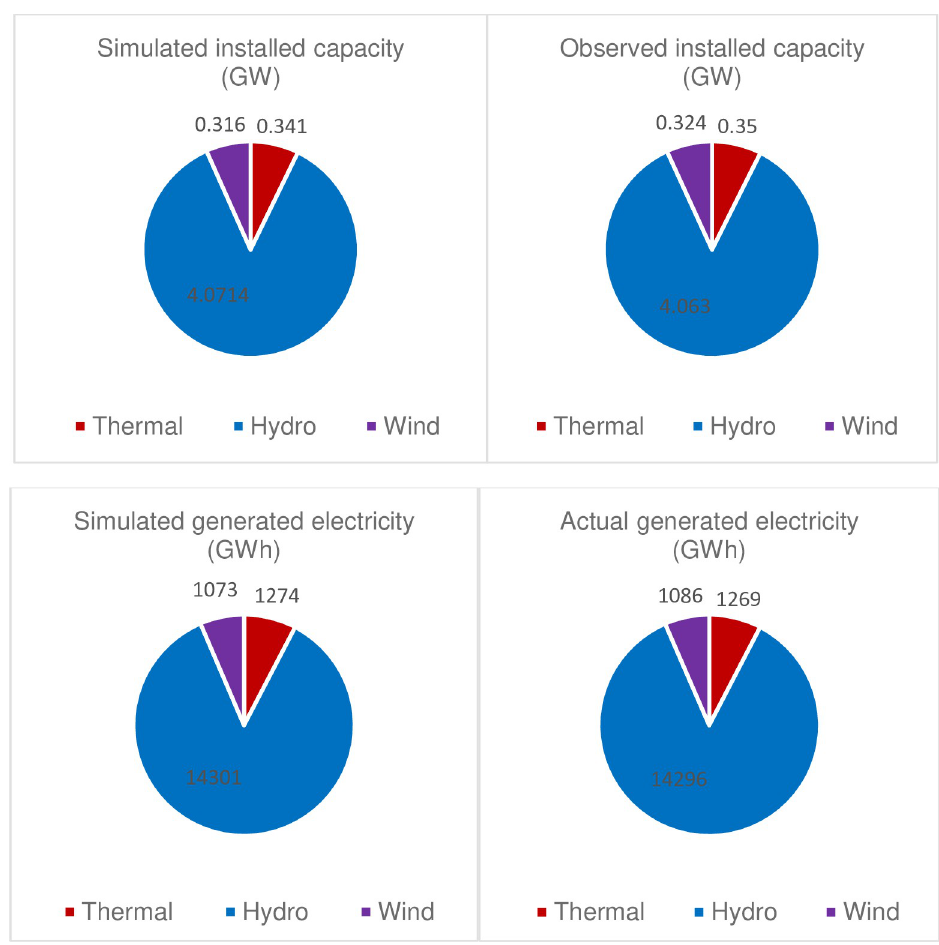
Fig 2. Model calibration for the base